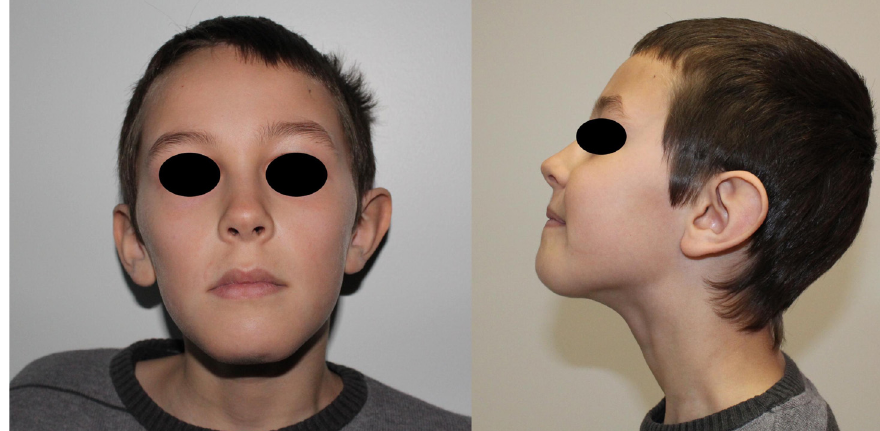
Fig. 5. Postoperative photographs of face from the front (top left) and pro fi le (top right) one and a half months after surgery, showing the disappearance of the chin